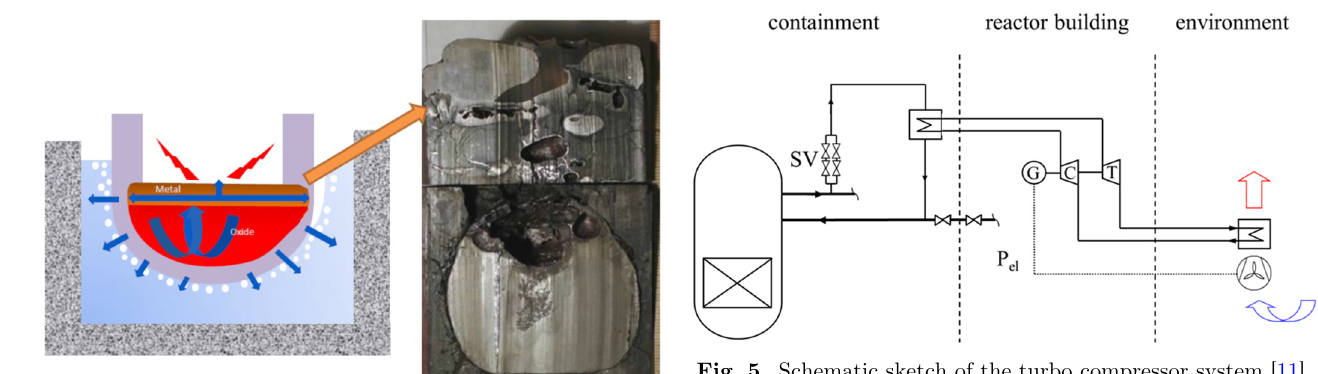
Fig. 5. Schematic sketch of the turbo compressor